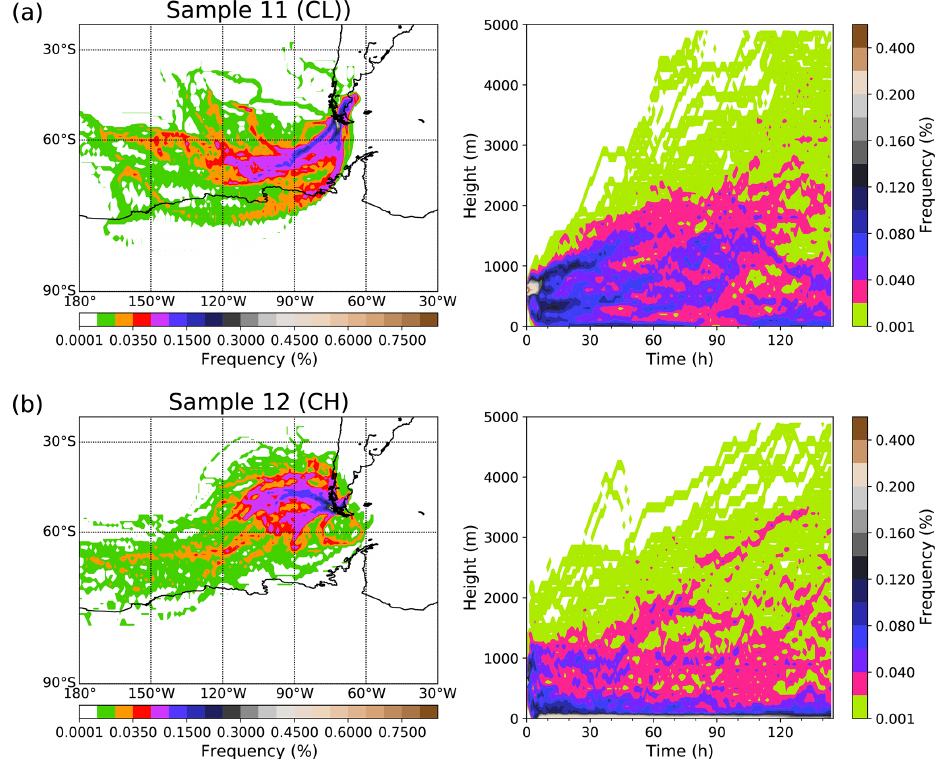
Figure 8. Relative frequency of backward trajectories ending at the Cerro Mirador site (600ma.s.l.) with 1h resolution, based on a 1 ◦ by 1 ◦ grid size (a, b) and the corresponding relative frequency of backward trajectory height (c, d) during sample 11 (a) and sample 12 (b) .